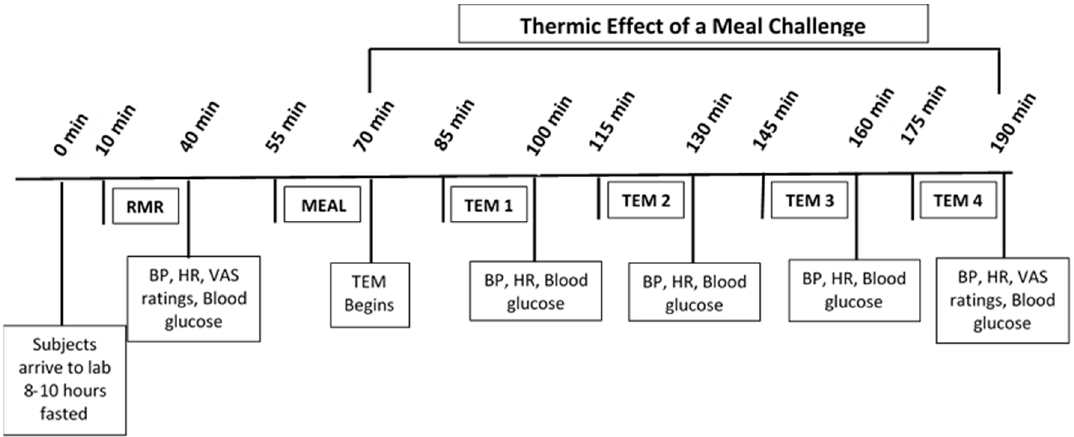
Figure 1. Timeline of thermic effect of a meal (TEM) test days. RMR: resting metabolic rate; BP: blood pressure; HR: heart rate; VAS: visual analog scales for hunger, fullness, satiation, desire to eat.